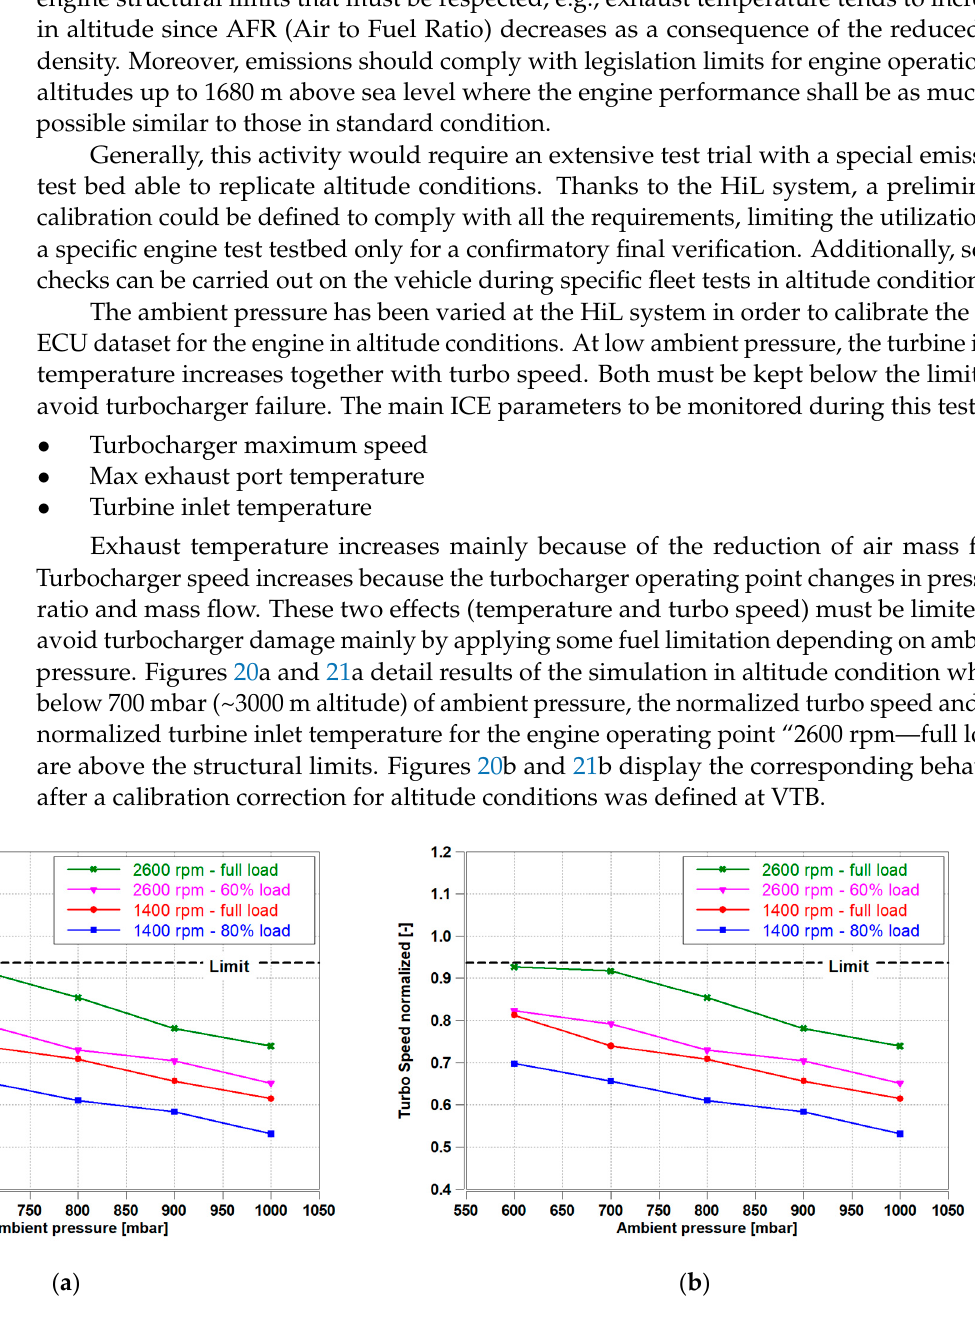
Figure 20. ( a ) Turbo speed w/o Altitude Calibration normalized with respect to the maximum value reached in the test; ( b ) Turbo speed w/ Altitude Calibration normalized with respect to the maximum value reached in the test w/o altitude calibration.